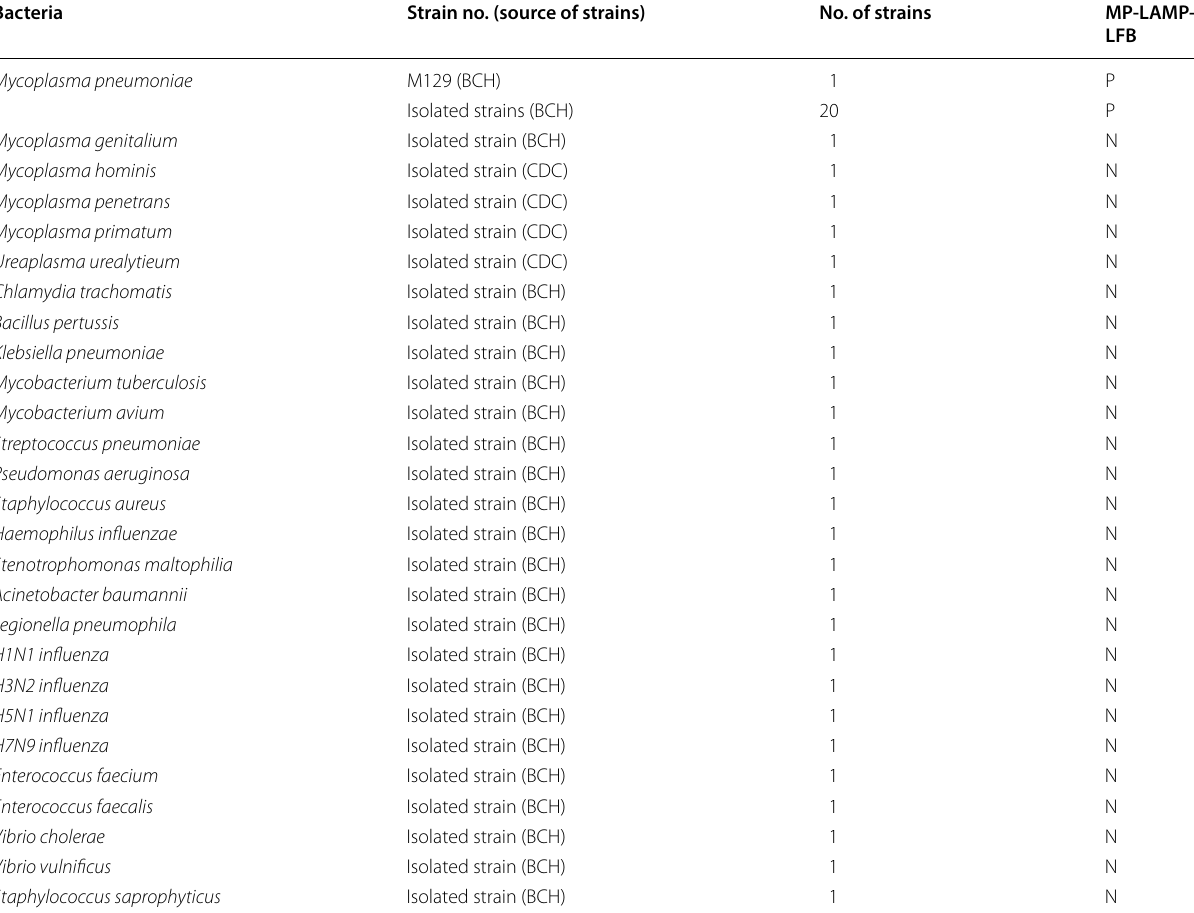
Table 1 Bacterial strains used in this study